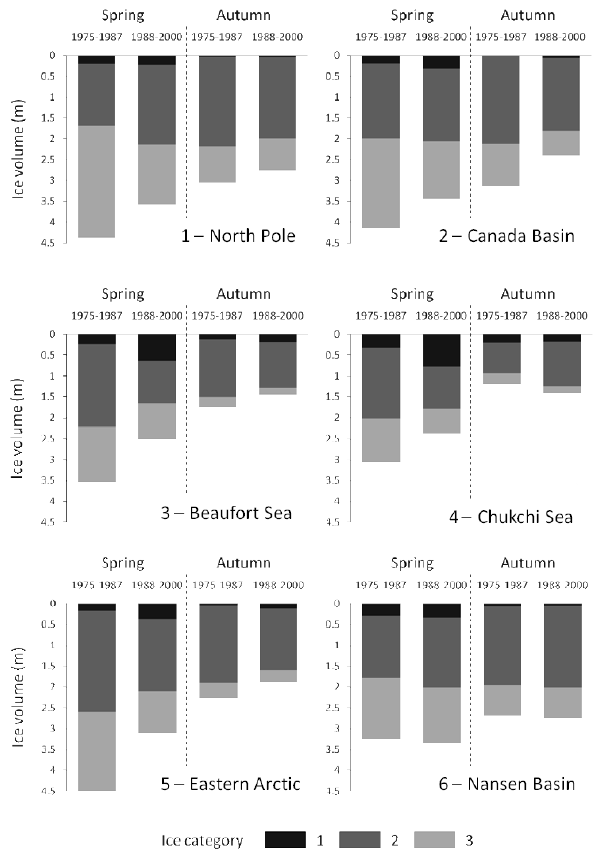
Fig. 6. Regional mean sea ice draft and its composition. Ice cat- egory 1 consists of ice with draft < 2m in Spring and < 1m in Autumn, ice category 2 includes draft range 2–5m in Spring and 1– 5m in Autumn, and all ice with draft > 5m falls into ice category